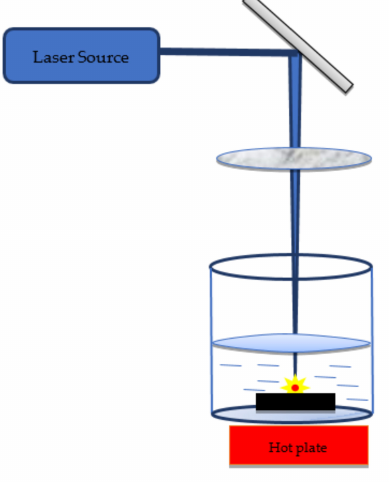
Figure 15. Illustration of temperature field-assisted pulsed laser ablation of solid metal targets in liquid